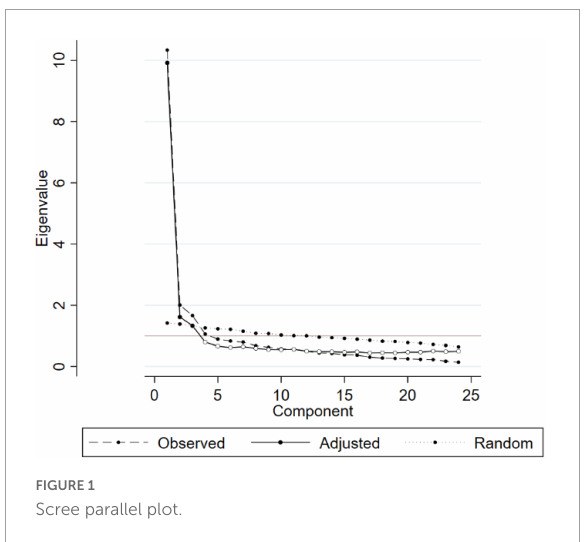
FIGURE1 Scree parallel